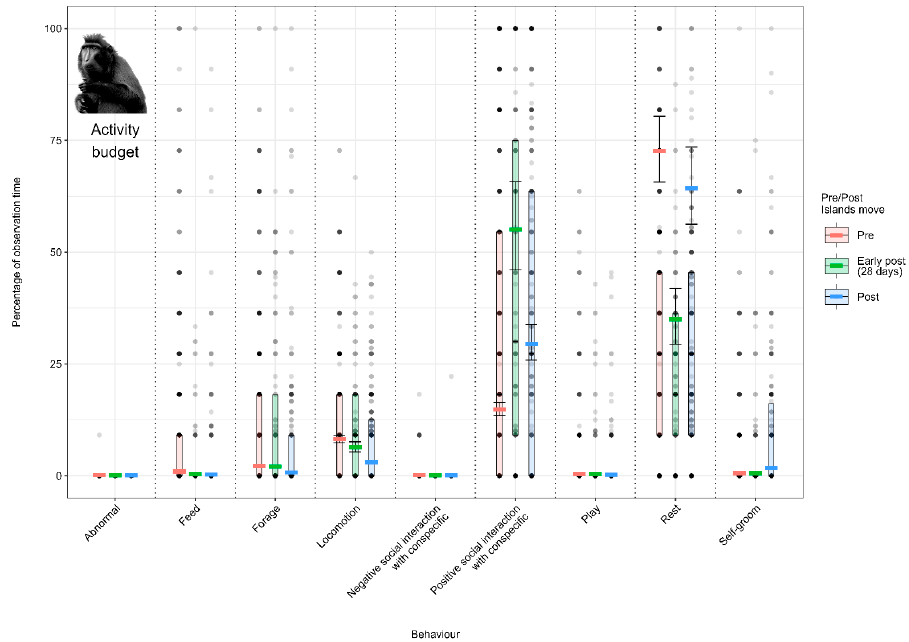
Figure 3. Proportion of time crested macaques spent performing each behaviour (expressed as a percentage of the total activity budget) under the pre-, early-post- and post-enclosure-move conditions. The model’s fitted values are represented by coloured horizontal lines, and their respective 95% confidence intervals are depicted as black error bars. Coloured boxes with black horizontal lines depict the medians and quartiles of the response. Grey dots represent raw data points, shaded according to frequency (dark indicates many observations, light indicates few).